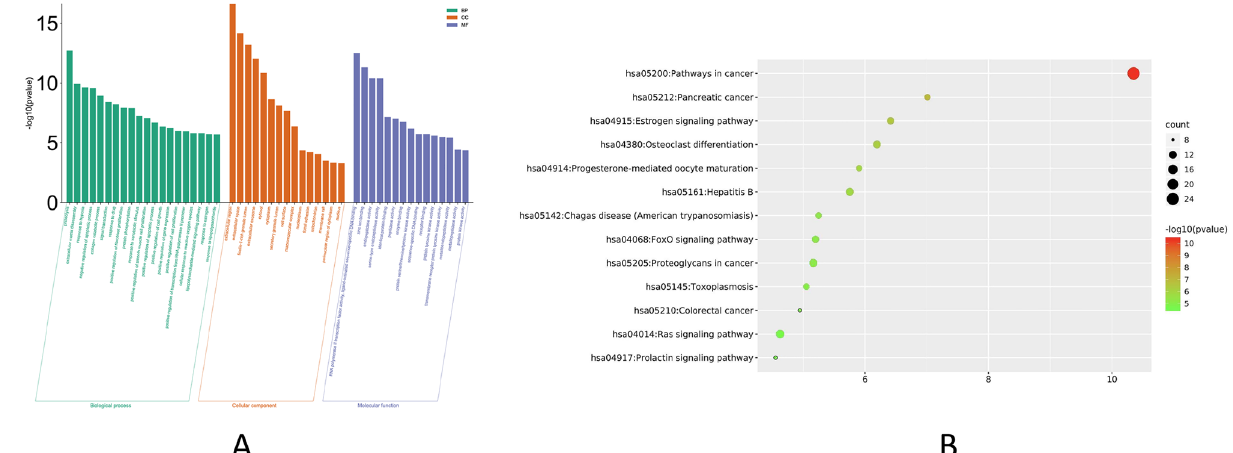
Figure 4. Functional enrichment analysis. ( A ) Enrichment analysis of potential targets of the active components of AA in rheumatism. The analysis of the Gene Ontology (GO) terms for biological process (BP), cellular component (CC), and molecular function (MF) is shown. LogP is the log-value of the P-value. P < 0.05 is considered significant. The results of the enrichment analysis are shown by LogP to present results intuitively. The count represents the number of genes, ( B ) Bubble diagram of KEGG enrichment analysis. The y-axis represents pathway and the x-axis represents gene ratio (amount of genes enriched in the pathway/amount of all genes in the background gene set). The size and color of the bubble represent the number of genes enriched in pathway and enrichment significance,